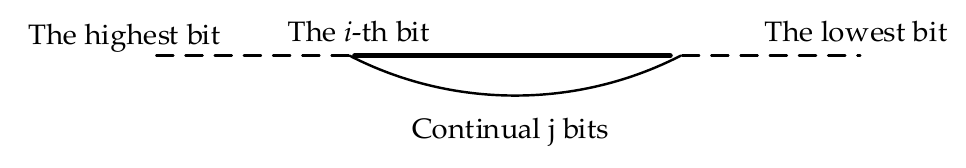
Figure 1. The schematic of 𝑏𝑖𝑡𝑠(𝑥, 𝑖, 𝑗) function.